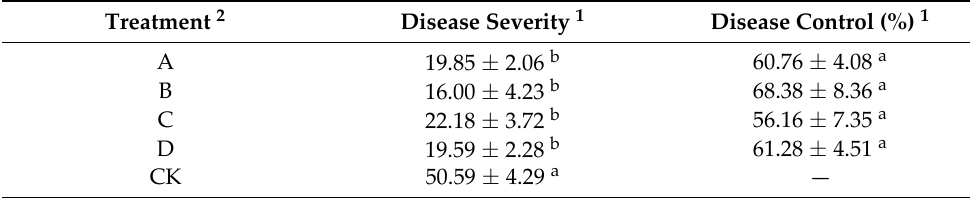
Table 4. Effect of the MR‑16 isolate on Fusarium wilt of S. divaricate . Treatment